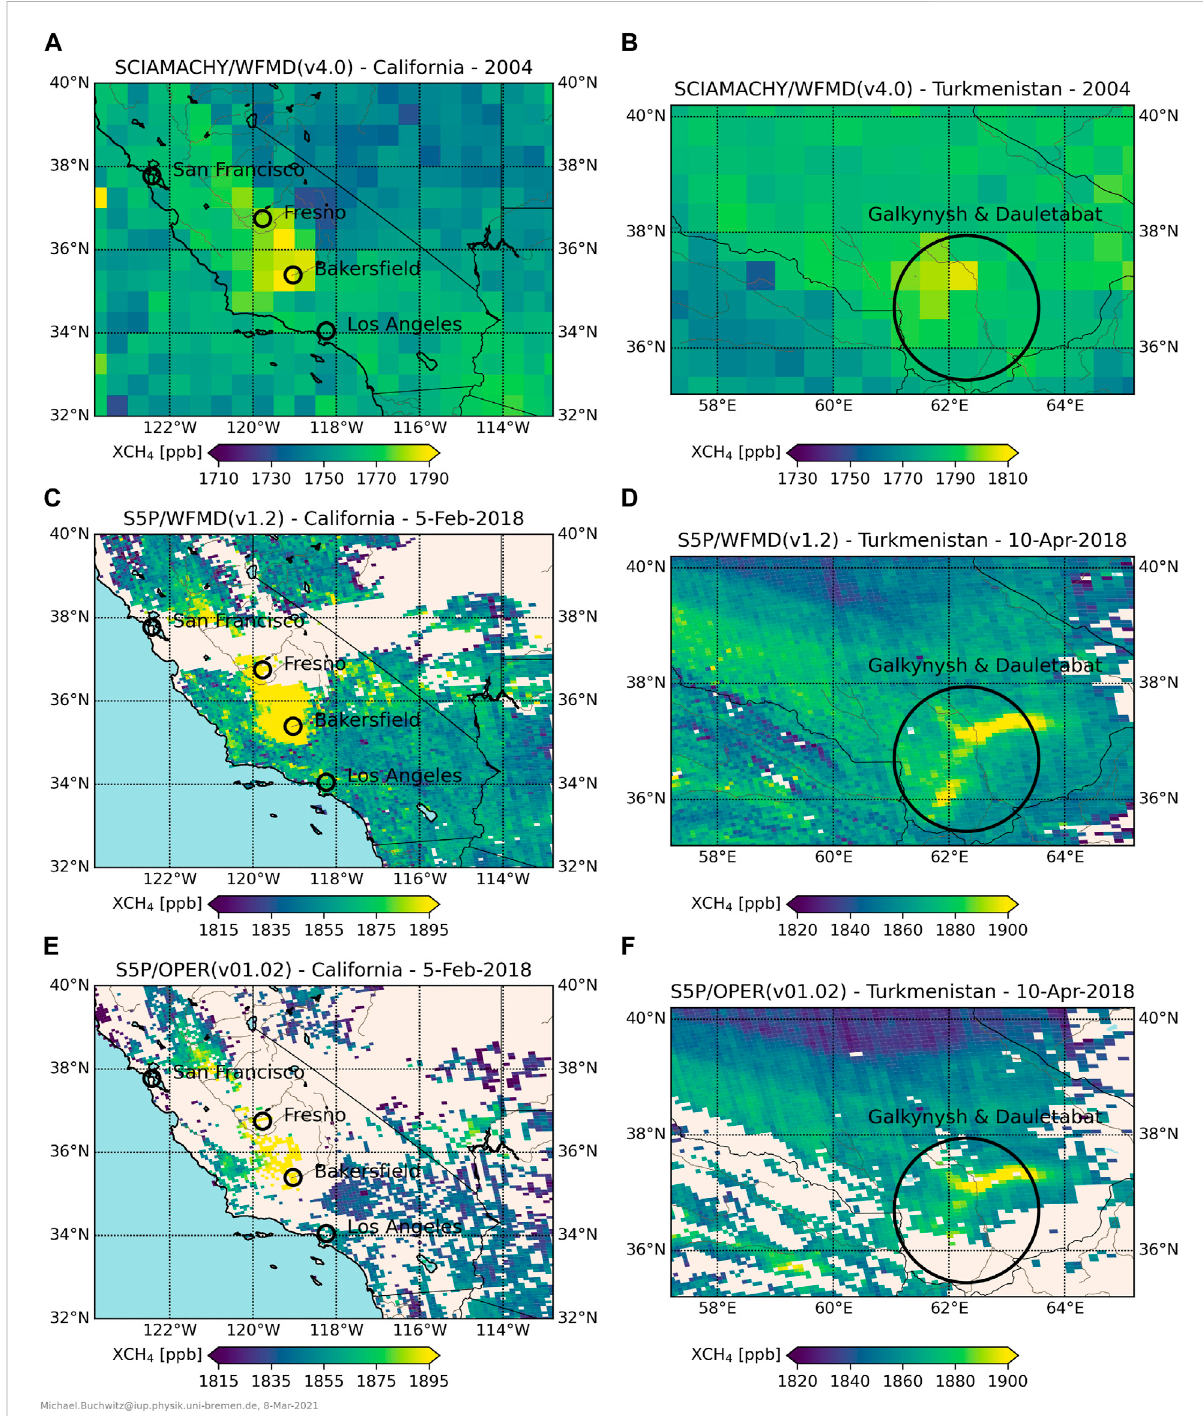
FIGURE 5 Satellite retrievals of column-averaged atmospheric methane (XCH 4 ) over major methane source regions. (A) SCIAMACHY XCH 4 retrievals at 0.5 ° × 0.5 ° resolution during 2004 over California (Buchwitz et al., 2017). (B) As (A) but for the Galkynysh and Dauletabad gas and oil fi elds located in south-east Turkmenistan. (C) Single overpass (5-Feb-2018) Sentinel-5P (S5P) XCH 4 retrieved with a research algorithm over California (Schneising etal.,2019;Schneisingetal.,2020). (E) As (C) butfortheoperationalS5PXCH 4 dataproduct(Huetal.,2018) (D,F) Sameasin (C,E) butforasingle overpass (10-Apr-2018) over Turkmenistan. The satellite observations yield information on hotspots of methane emissions, which can be used by local policy-makers and stakeholders to identify targeted mitigation